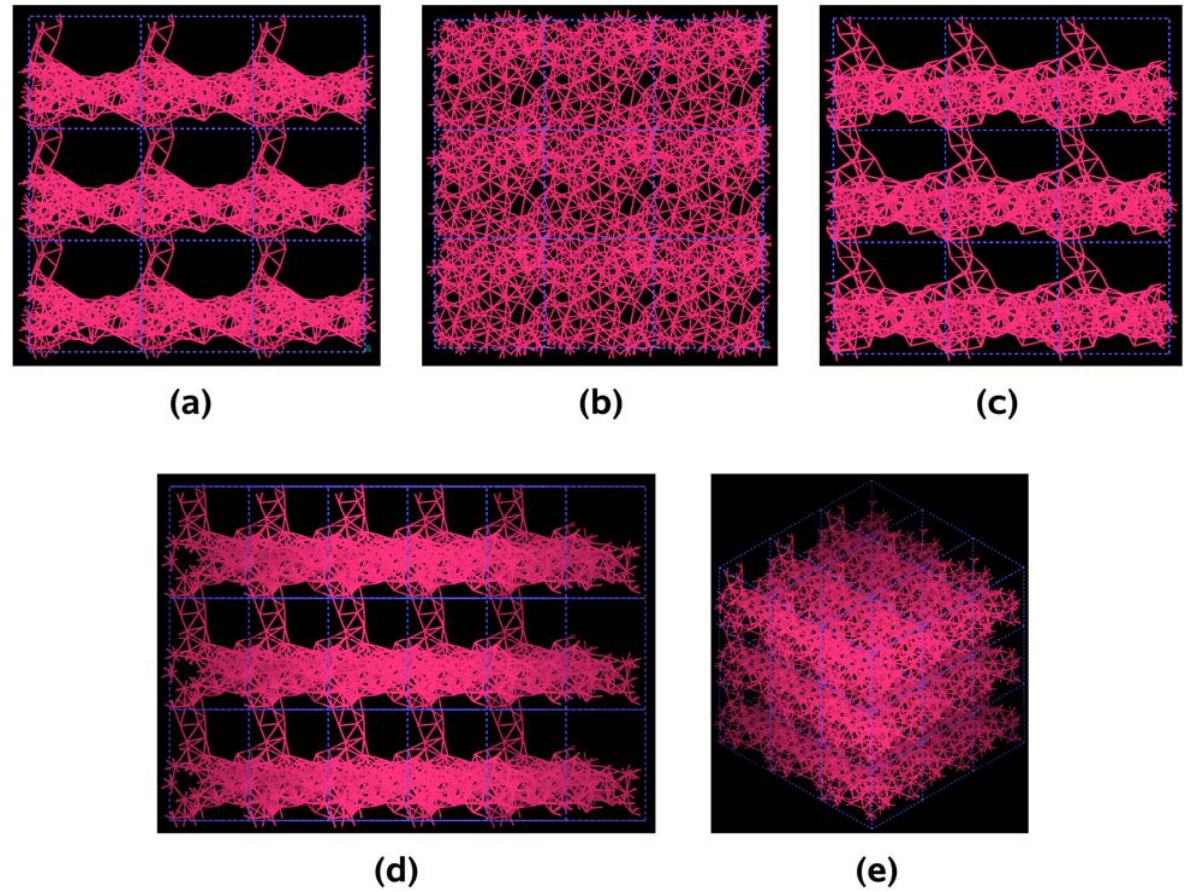
Figure 23. Pores (layers) formed in a 3 × 3 × 3 50% porosity supercell with 108 aluminum atoms when it undergoes an MD process at 918 K during 500 steps. There are prominent through pores, almost layers, along (a) x, (c) z and (d) xz